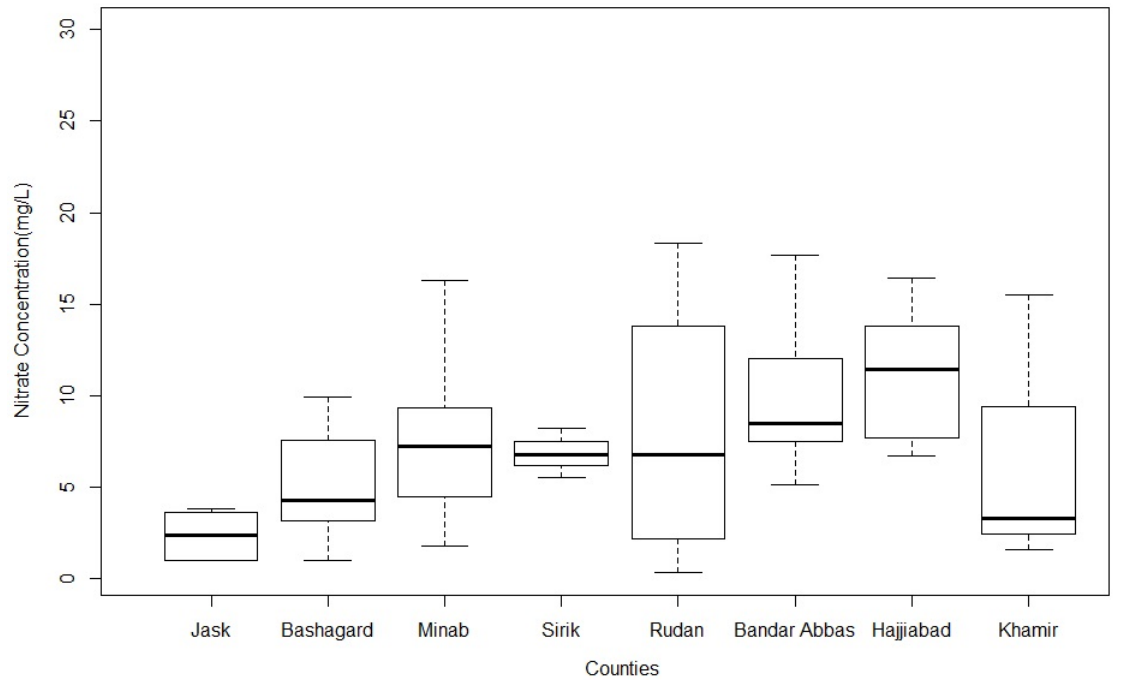
Figure 3. Box plots and Kruskal-Wallis test results for different counties of Hormozgan province.